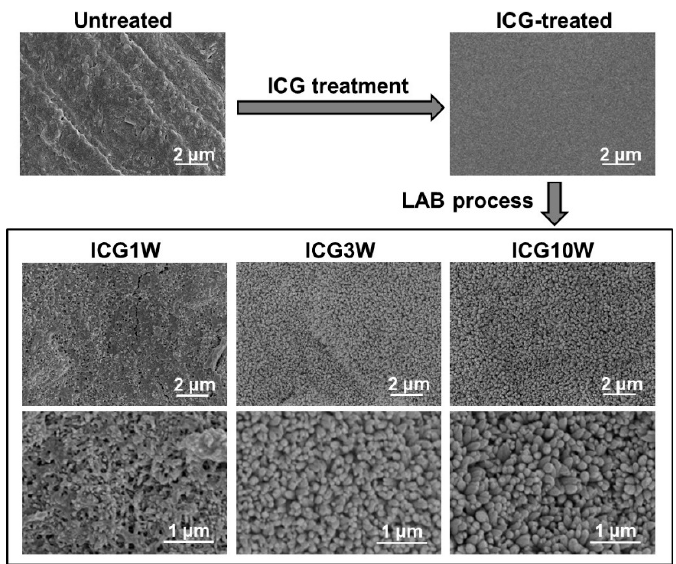
Figure 2. SEM images of the surfaces of the untreated substrate (top-left), ICG-treated substrate (top-right), and LAB-processed substrates: ICG1W (left), ICG3W (middle), and ICG10W (right), with lower (middle row) and higher (bottom row)